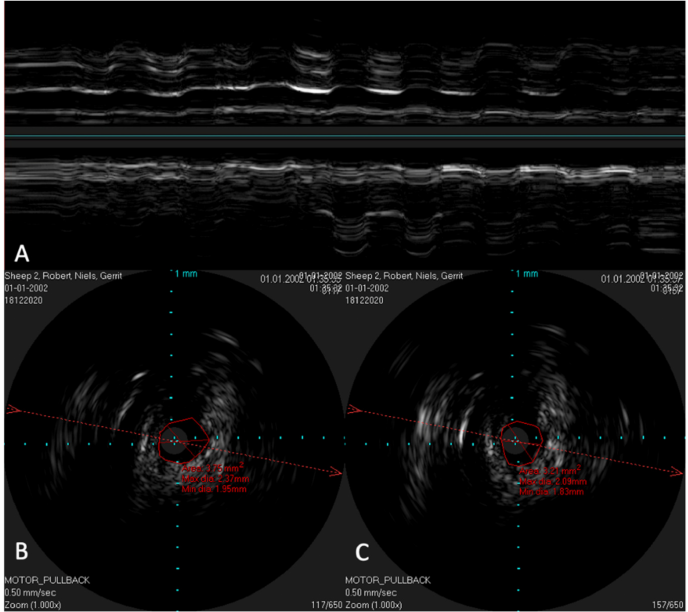
Figure 9. Ultrasound image of the ET with a stationary IVUS probe. During the scan, the lower jaw was repeatedly moved manually, thus opening and closing the sheep’s mouth. Image ( A ) shows